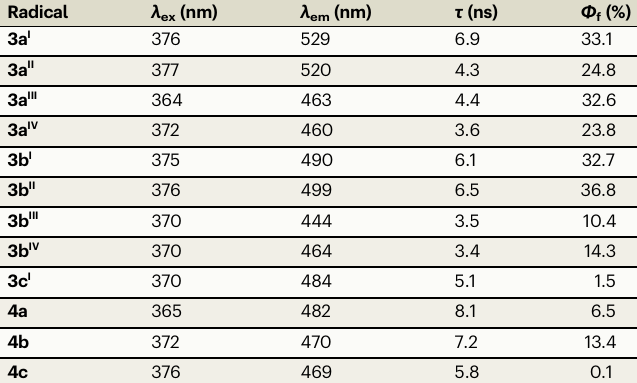
Table 1 | Photophysical parameters of NHC-based lumines- cent radicals 3a – c and 4a – c in THF